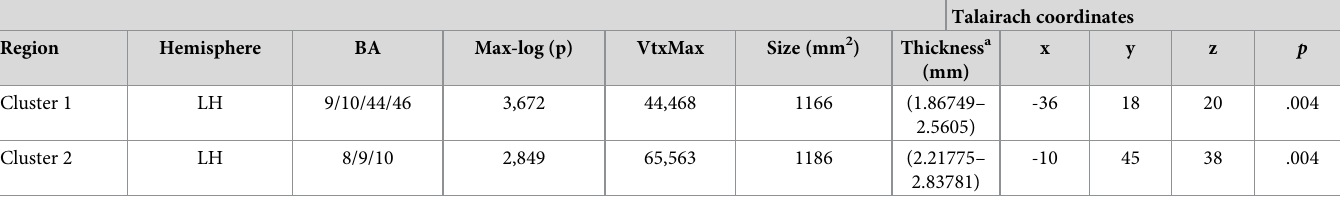
Table 4. Clusters of significant altered cortical thickness between HIV-infected patients groups.